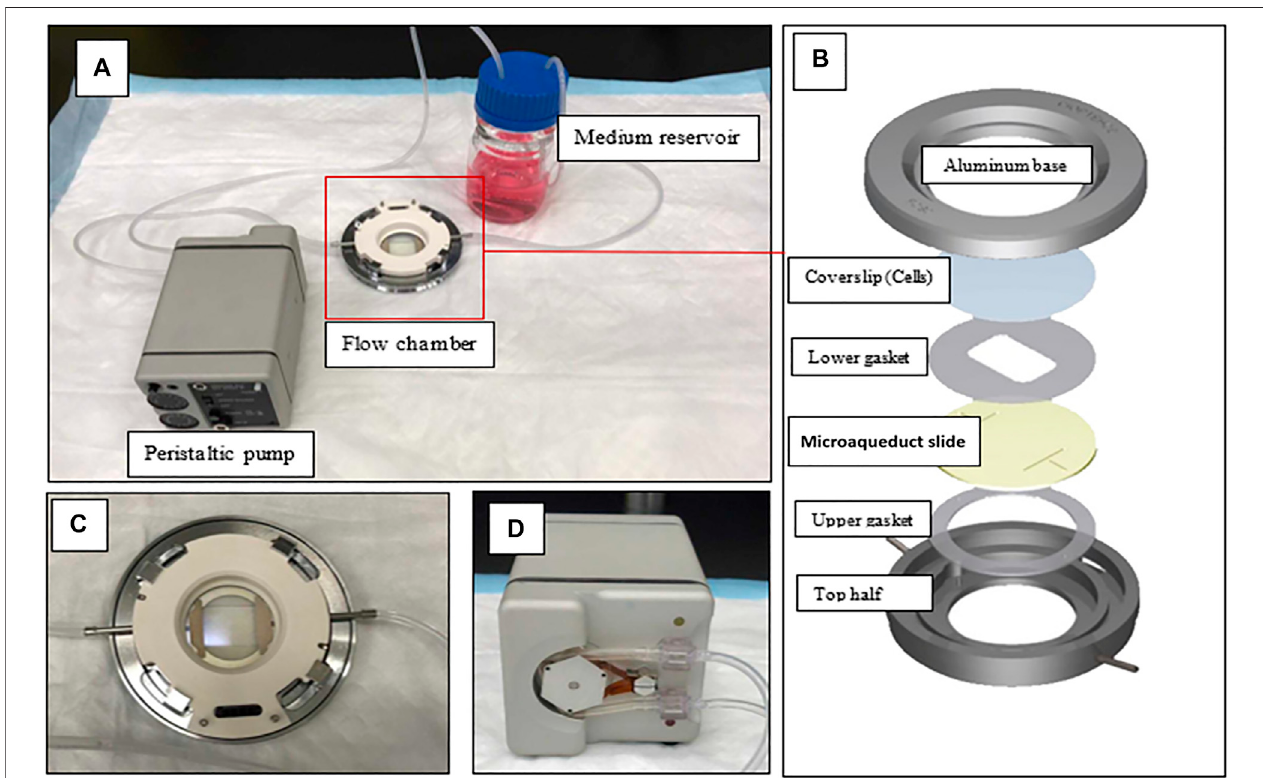
FIGURE1| Flowchambersetup. (A) The fl owchamberisconnectedtotheperistalticpumpfromonesideandthemediumreservoirfromtheothersideinaclosed circuit. (B) Flow chamber assembly. (C) The fl ow chamber closer view (D) Back view of the peristaltic pump.